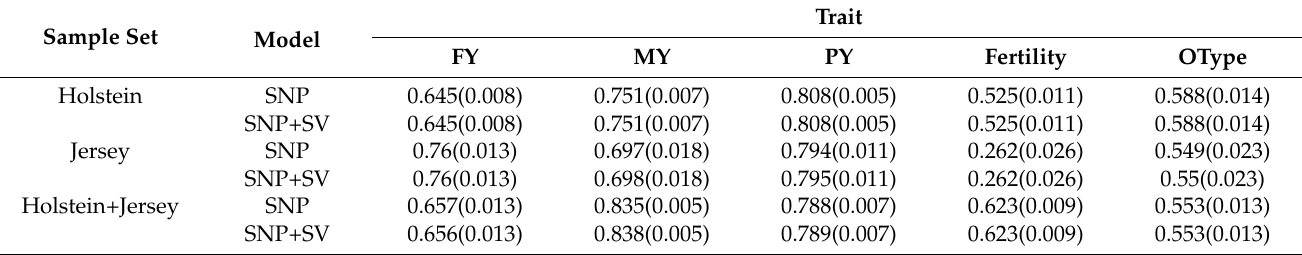
The number represents the proportion of variance that each item explained in the phenotypic variance for each trait. SNP: SNP variance; SV: SV variance; SUM: total genetic variance. The last column is the percentage of genetic variance explained by SV. Table 5. Prediction accuracy for each trait in Holstein, Jersey and mixed Holstein and Jersey bulls with SNP only and SNP + SV together in 10-fold